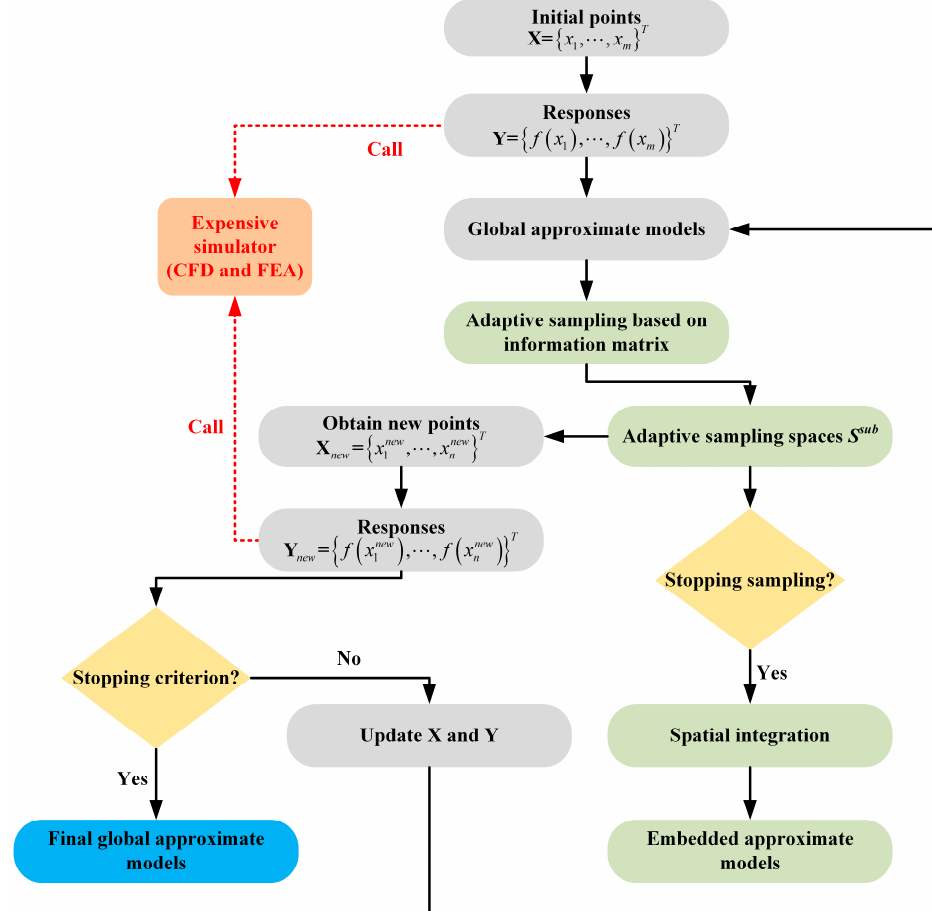
Figure 7. Flowchart of the information matrix-based dynamically embedded approximate models.